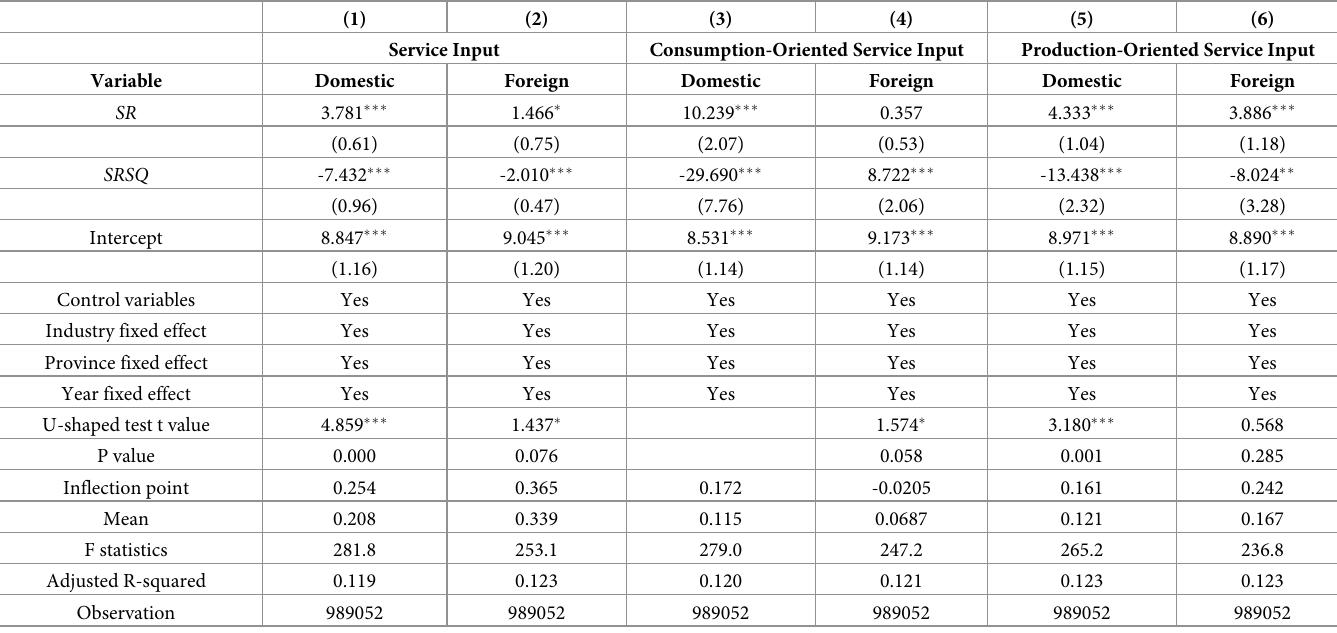
Table 7. The results of service input source (1).